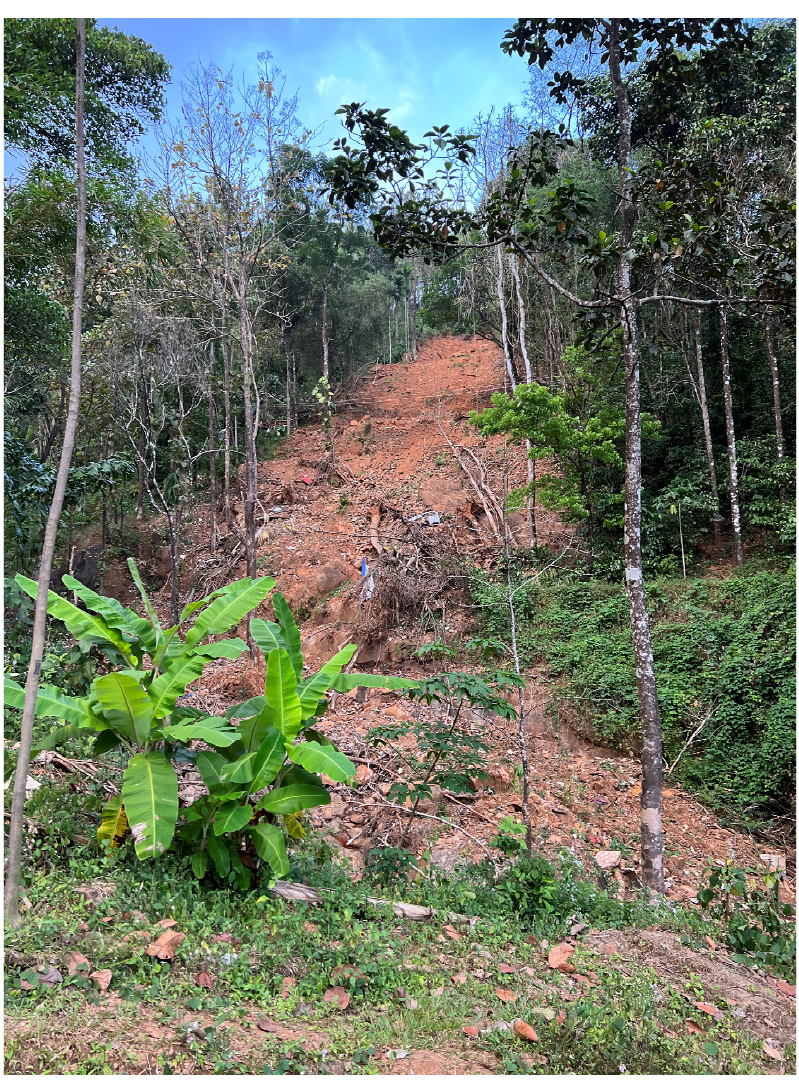
Figure 1. The Kavali landslide resulted in the demolishment of one house and the death of six peo- ple.